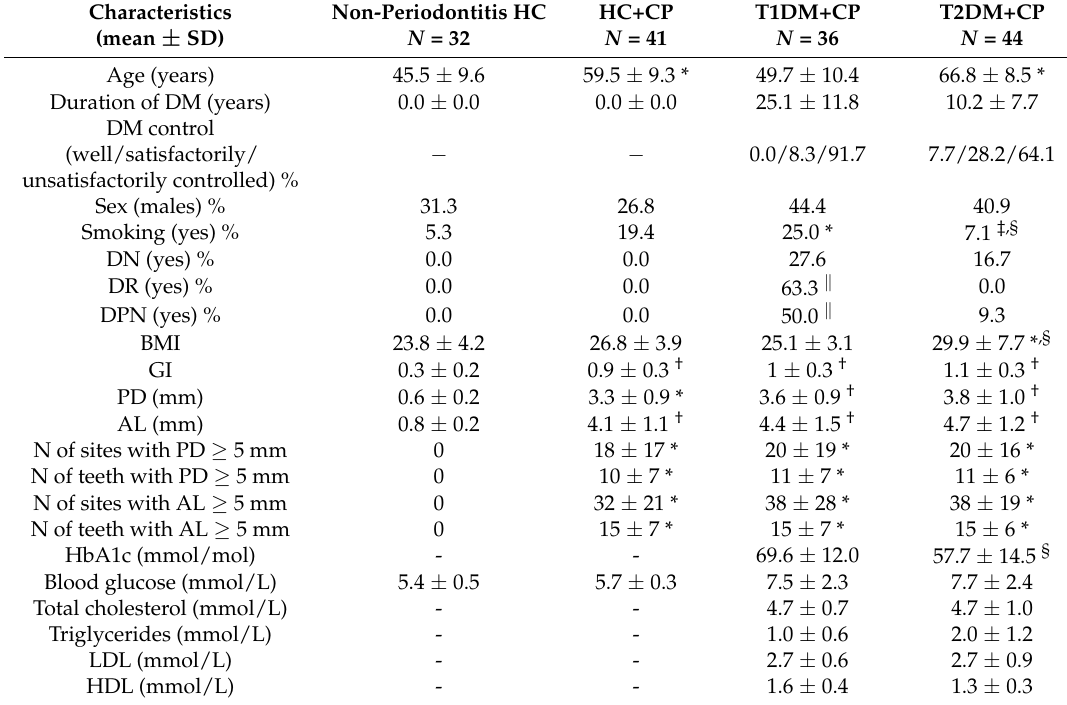
Table 1. Demographic data for the studied T1DM+CP and T2DM+CP patients as well as HC+CP and non-periodontitis